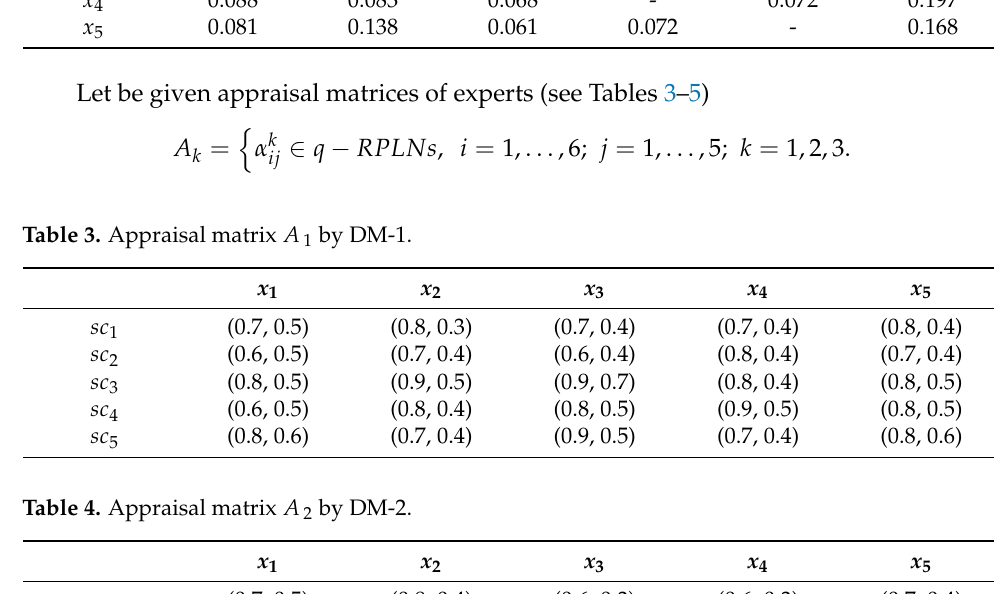
] and importance val- ; M + ij ij